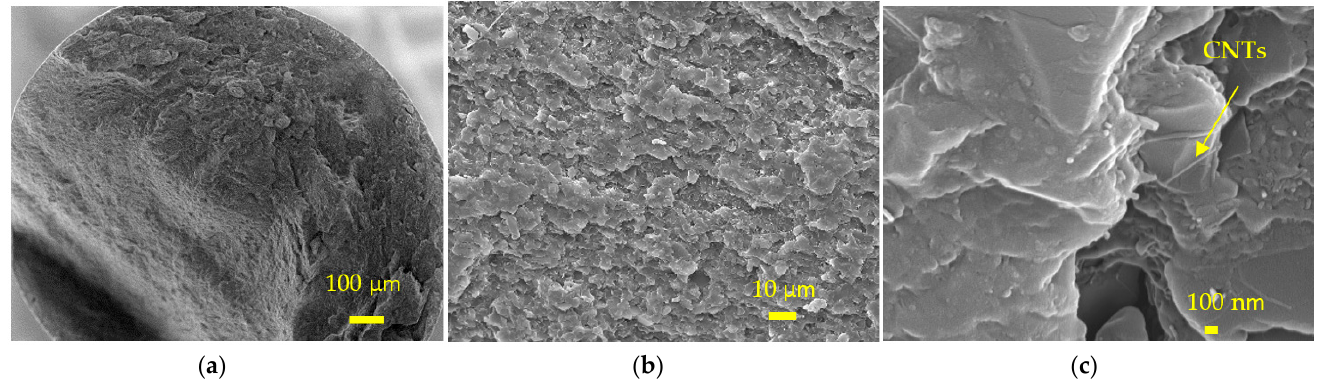
Figure 8. SEM fractography of the PA12-15wt%GNPs+1wt% CNT sample ( a ) the fracture, ( b ) an enlarged area, and ( c ) the CNTs in the composite.